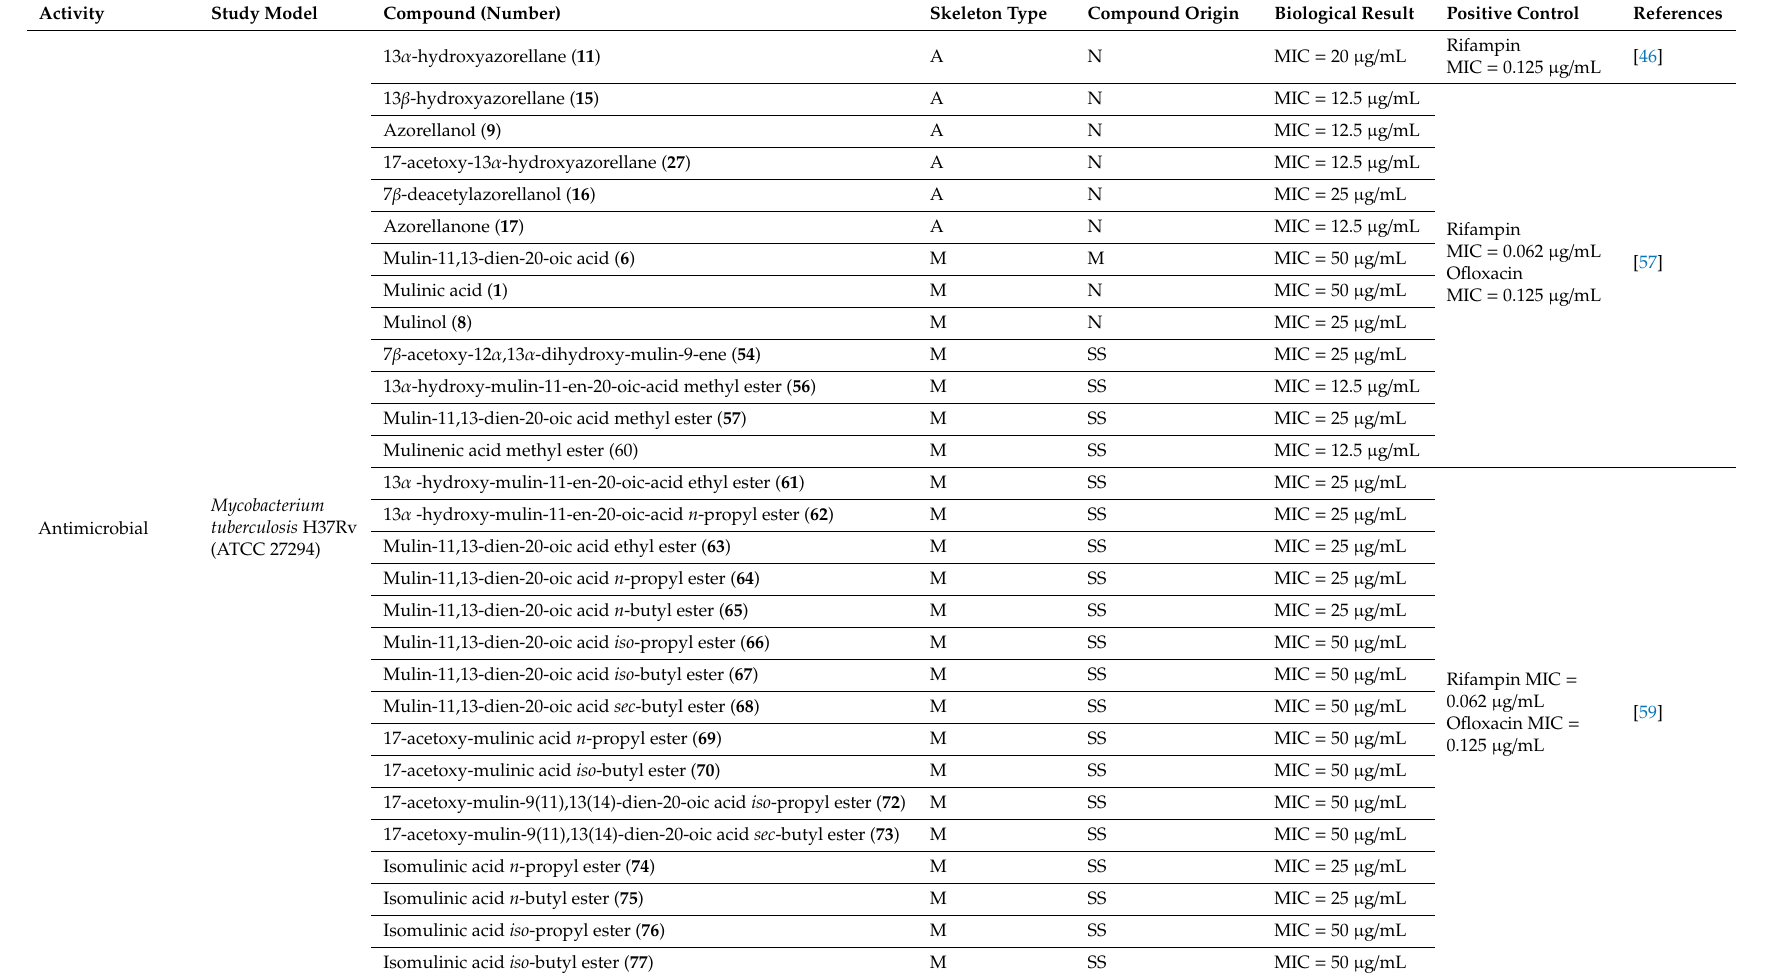
Table 5. Pharmacological activities of mulinanes and azorellanes. MIC: Minimal Inhibitory Concentration; ZI: Zone of inhibition; LD 50 : Median Lethal